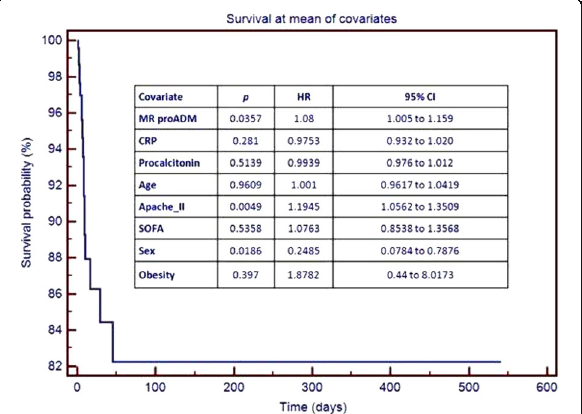
Fig. 3 (abstract 0124). multivariate analysis (Cox proportional hazards